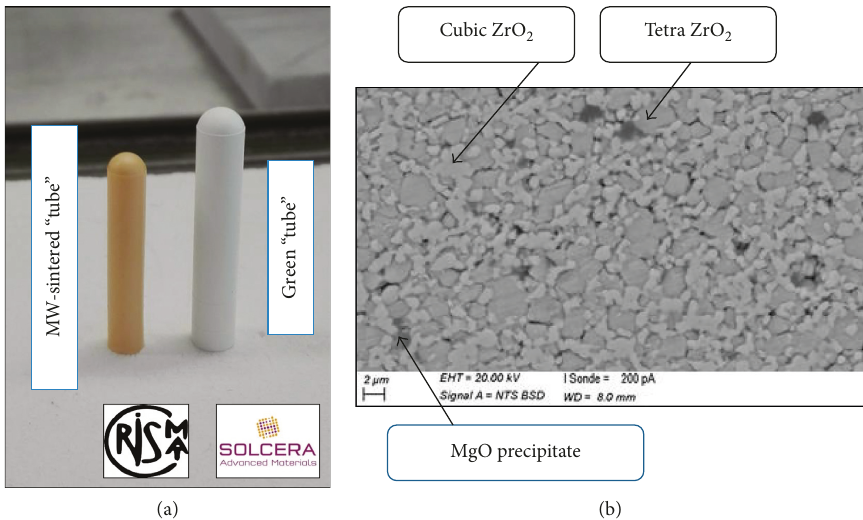
Figure 7: (a) Photograph showing the zirconia material tube before and after microwave sintering. (b) SEM microstructure of MgO- stabilized microwave-sintered